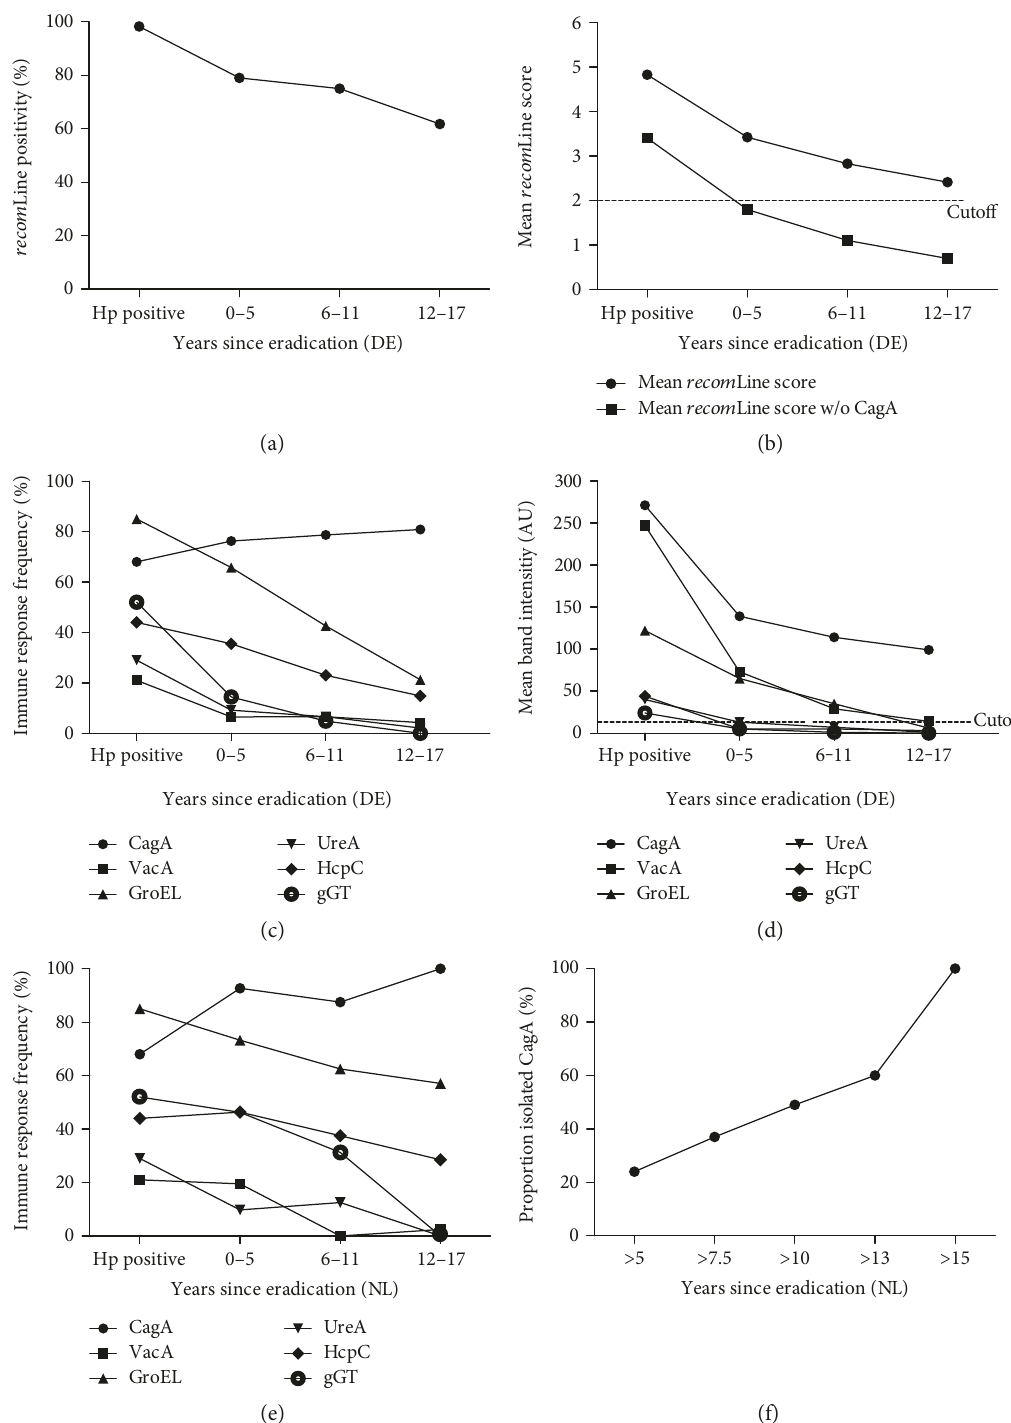
Figure 1: recom Line test results from patients without and with eradication therapy. (a) recom Line positivity, (b) mean recom Line score, (c) immune response frequency, and (d) mean immune response intensity of individuals with an active ongoing H. pylori infection ( n =402) compared to individuals having received antibiotic treatment in the past ( n =210), indicated as Hp positive years since eradication years since eradication and grouped (0 – 5, 6 – 11, and 12 – 17 years) analysing a German cohort (DE). Moreover, the relationship between (e) immune response frequency to individual antigens ( ● CagA, ■ VacA, ▲ GroEL, ▼ UreA, ♦ HcpC, and ○ gGT) and (f) percentage of isolated CagA immune response and the time since eradication therapy analysing a Dutch cohort (NL) ( n = 65 ). While the immune response for all antigens tested declines after eradication, the response towards CagA antibodies persists over a long period, resulting in an isolated CagA positivity, which remains above cuto ff and is signi fi cantly increased ( p < 0 01 ) in the 12 – 17 years group compared to all other